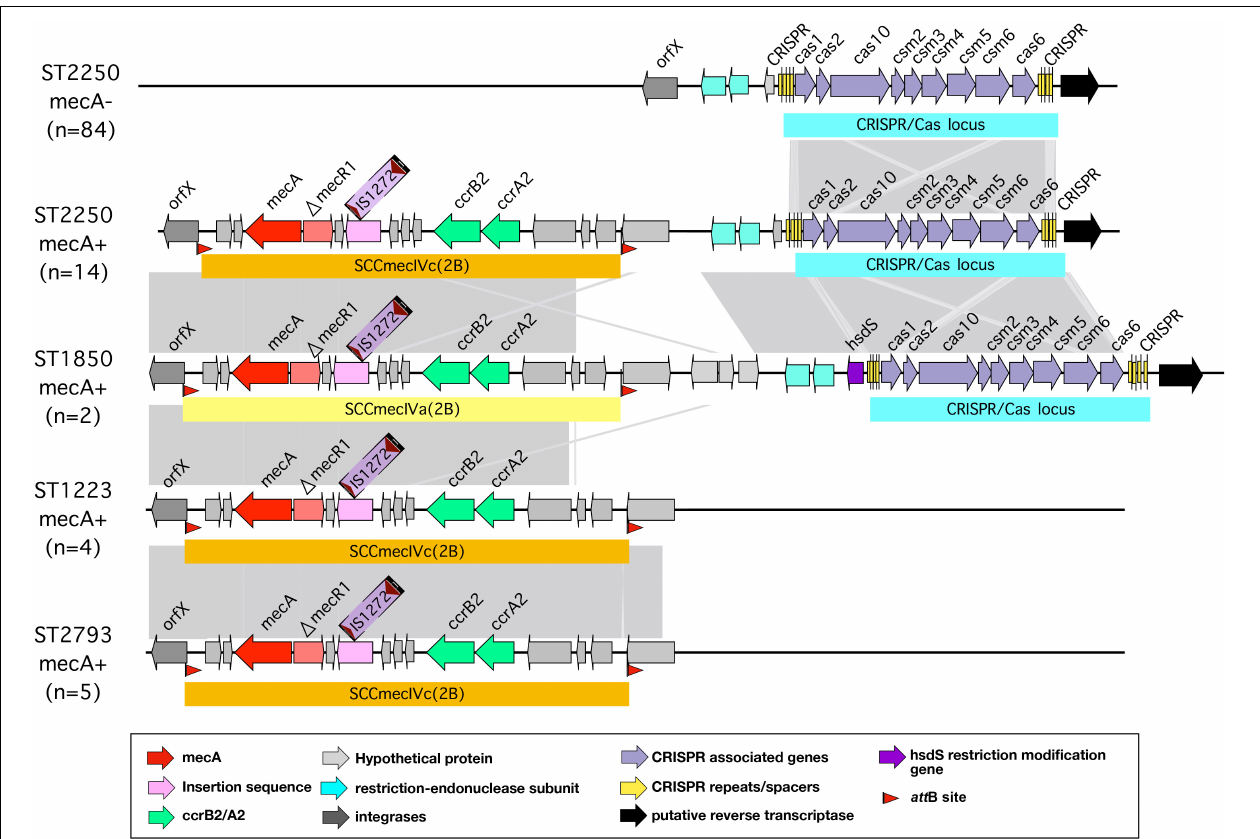
FIGURE 7 | CRISPR/Cas locus in different strains of S. argenteus . Arrangement of the CRISPR/Cas locus within the orfX region of different strains of S. argenteus with and without the mecA cassette. For comparison, the mecA cassette in strains without the CRISPR/Cas locus are also shown.